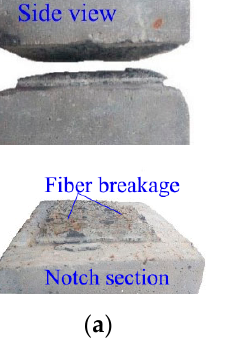
Figure 6. Typical failure patterns of axial tensile specimens : ( a ) fiber breakage of HFb04; ( b ) fiber pull-out of HFb12.